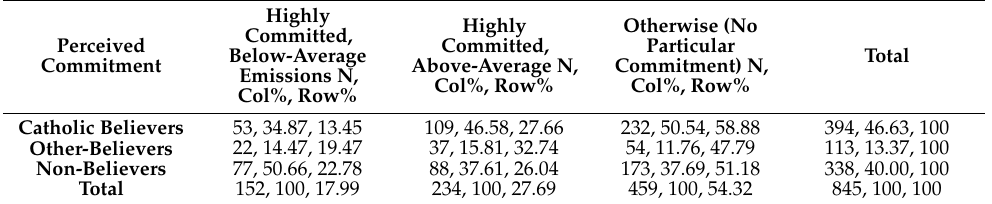
Table A7. Cross-table religious groups and perceived commitment.